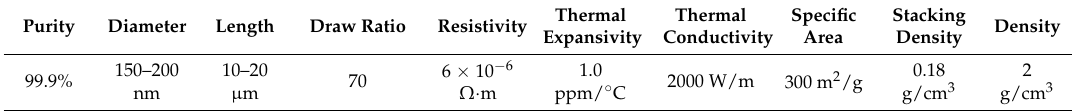
Table 2. Physical parameters of carbon nanofiber.